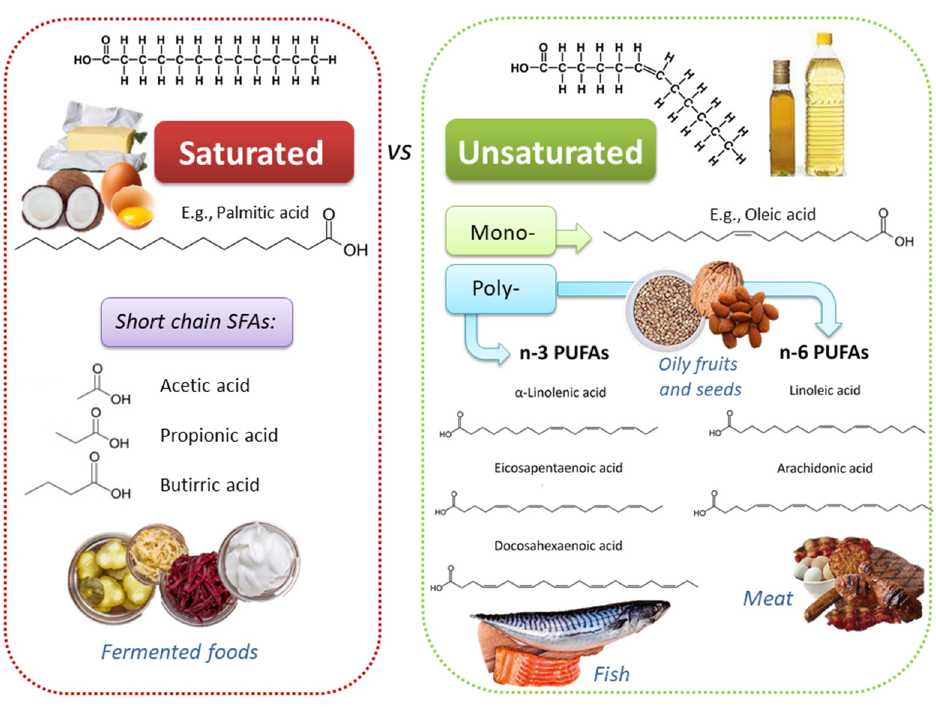
Figure 1. Chemically diverse lipid sources, with heterogeneous physico-chemical and biological properties, can be found in different foods.